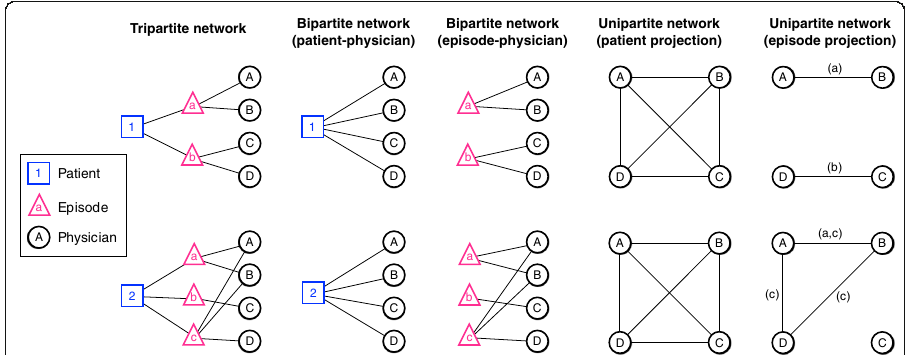
Fig. 1 Schematic of different network types associated with physician encounter data. Here the underlying physician visit sequence for Patient 1 is A, B, C, D, and these visits are associated with episodes a, a, b, b, respectively; the physician visit sequence for Patient 2 is A, B, C, A, C, D, B, and the associated episode sequence is a, a, b, c, b, c, c, respectively. The tripartite network connects a patient to one or more episodes, and each episode in turn is connected to one or more physicians. Tripartite networks provide the most complete presentation of the data and preserve all relevant information for network construction. The tripartite network can be projected to three different bipartite networks, each generated by omitting one node type from the tripartite network; here two bipartite networks are shown, one connecting patients and physicians and the other connecting episodes and physicians. Finally, any bipartite network can be projected to two different types of unipartite networks containing nodes of only one type. Here we show one projection for each bipartite network, the projections where the remaining nodes are physicians who are connected either by shared patients or shared episodes. Because of the organization of the tripartite network, we stress that all physician-physician ties are induced by shared patients, but the episode-based approach stipulates the additional constraint that only patients shared within episodes should